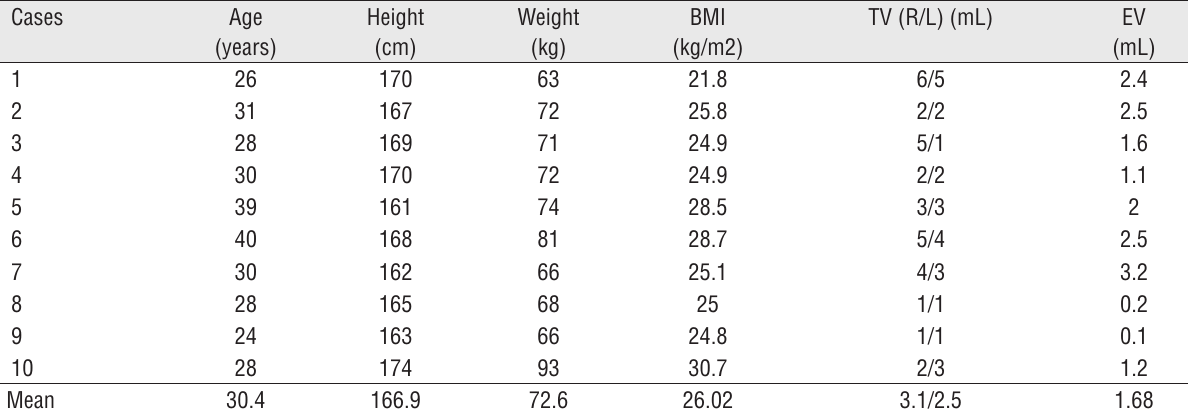
Table 1 - clinical data and semen volume analysis. Cases